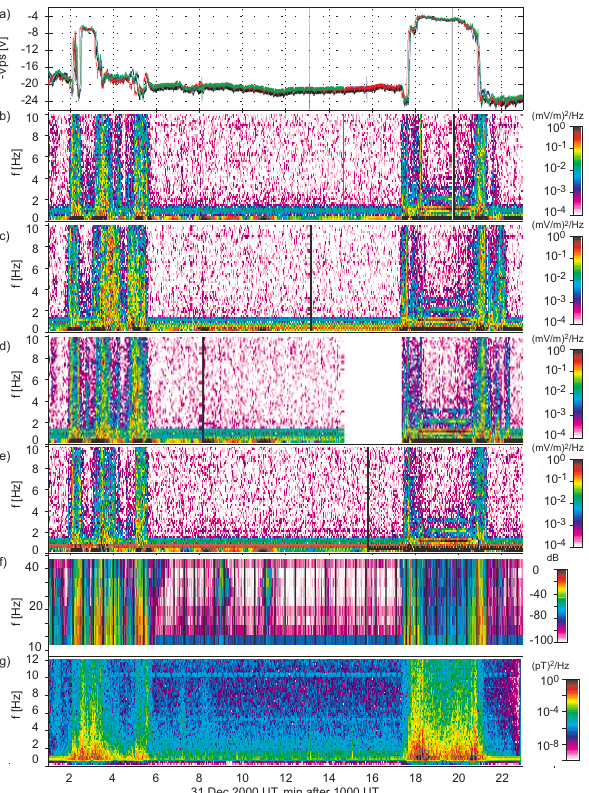
Fig. 2. Cluster observations from 31 December 2000. Panel (a) shows the potential v ps from EFW (satellites 1–4 correspond to black, red, green and blue, respectively). A v ps of –20, –10 and –5 V corresponds to about 0.8, 2 and 20 particles cm − 3 . Panels (b–e) display EFW E y electric field up to 10 Hz. (The signal from around the satellite spin frequency (0.25 Hz) to 1 Hz is primarily artificial, see text). Panels (f) and (g) show satellite 4 STAFF electric fields (10–50 Hz) and the total magnetic (up to 10 Hz) fields, respectively. Note the broadband electric emissions at the potential gradients, and the magnetic emissions in regions of high v ps .